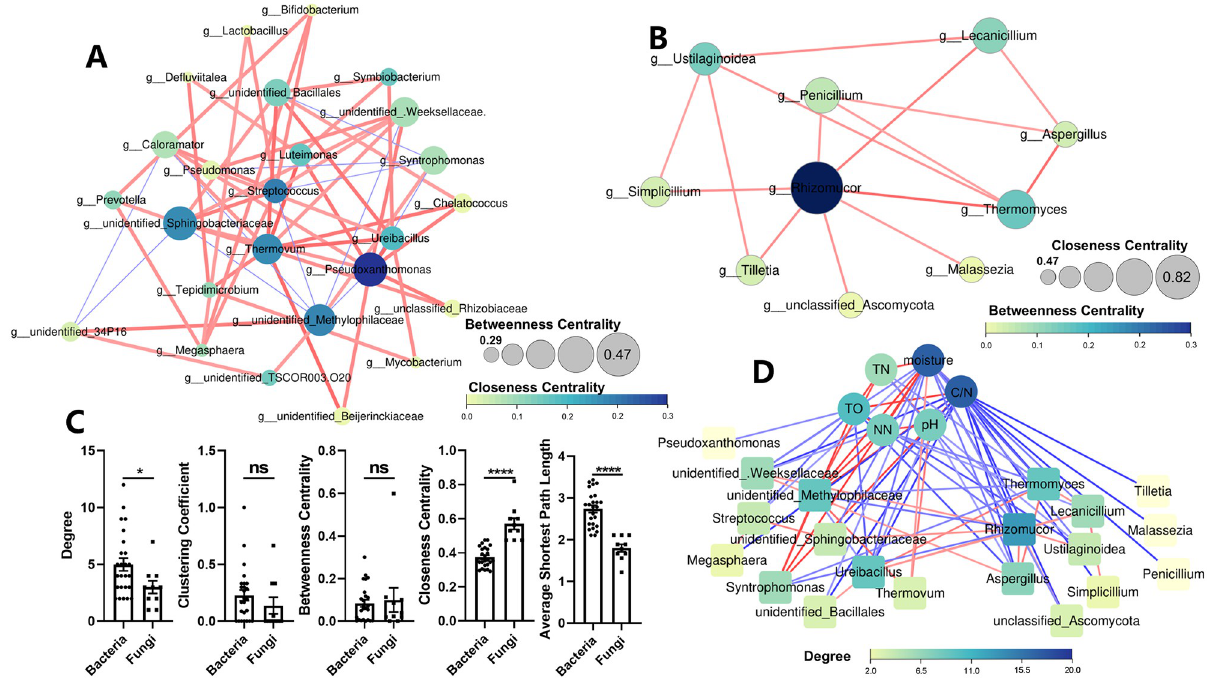
Fig 8. Network analysis of bacterial and fungal community and correlation between keystone genus and environmental factors. In bacterial (A) and fungal (B) network, nodes in the network represent taxon (genus level), and node size is proportional to closeness centrality, while node color is proportional to betweenness centrality; blue edge indicates negative correlation and red edge indicates positive correlation. Topological properties of nodes in bacterial and fungal networks (C). Correlation among keystone genus in bacterial and fungal network and environmental factors (D), and blue edge indicates negative correlation and red edge indicates positive correlation, while node color is proportional to degree.